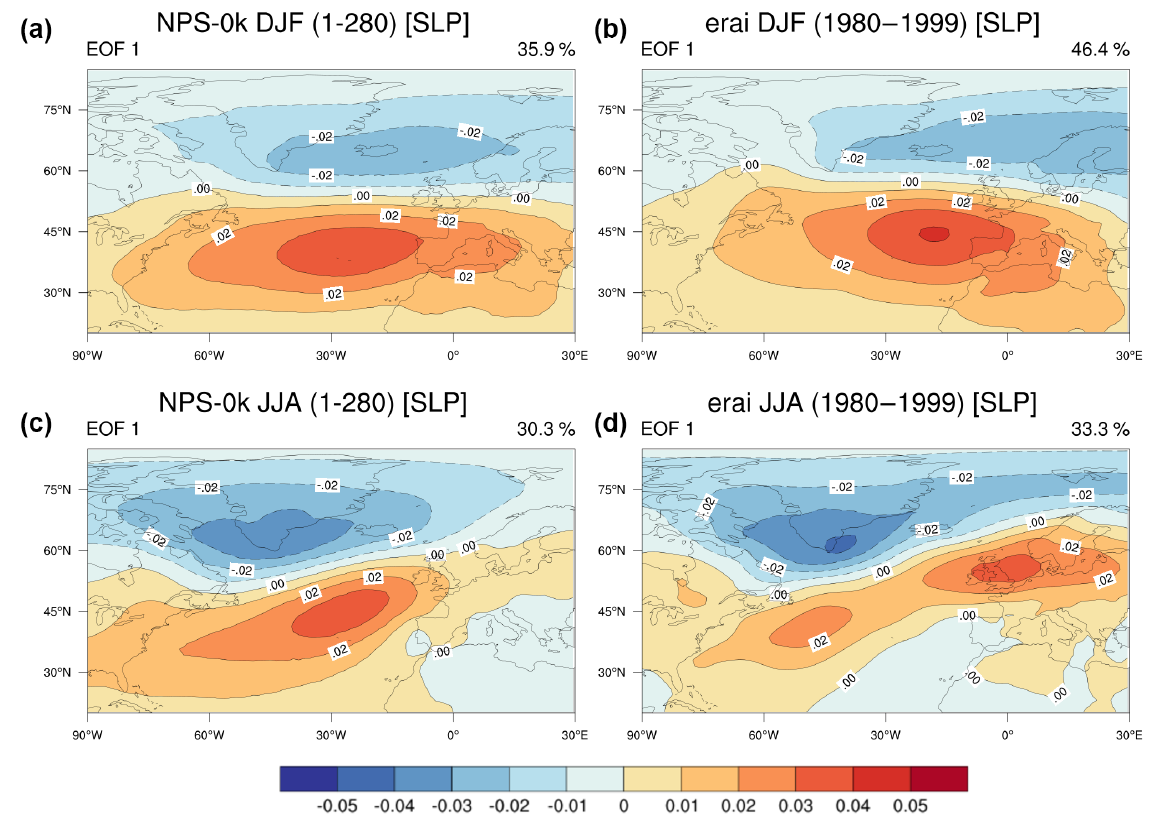
Figure 3. Leading EOF of SLP for (a, c) NPS-0k (years 1–280) and (b, d) ERA-Interim (years 1980–1999) in winter (DJF, a, b ) and in summer (JJA, c, d